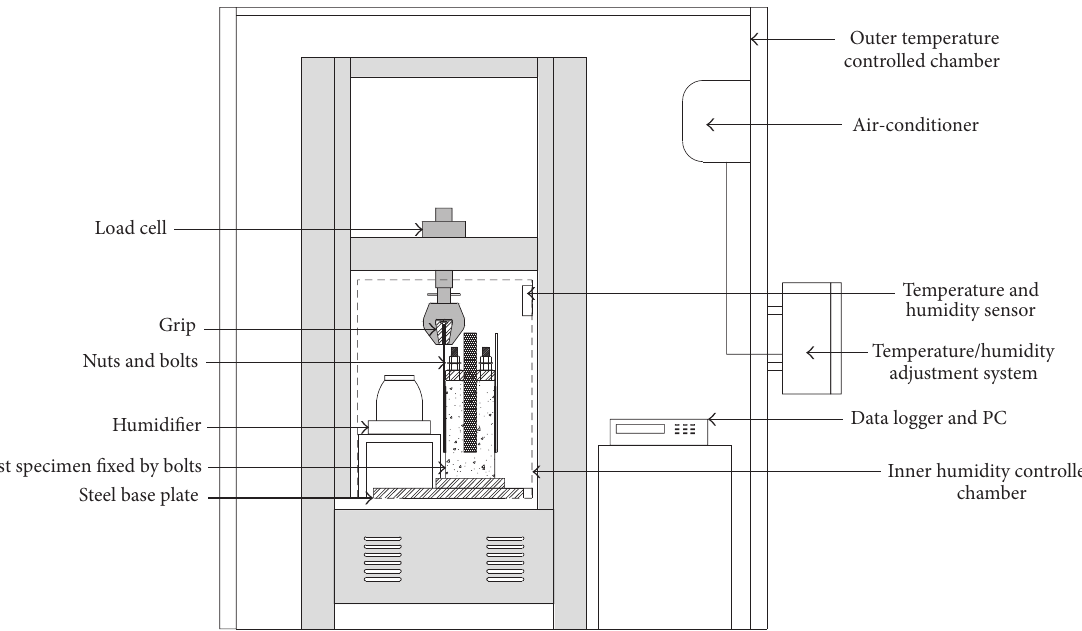
Figure 2: Test arrangement schematic for the bond specimen inside the environmental testing chamber.